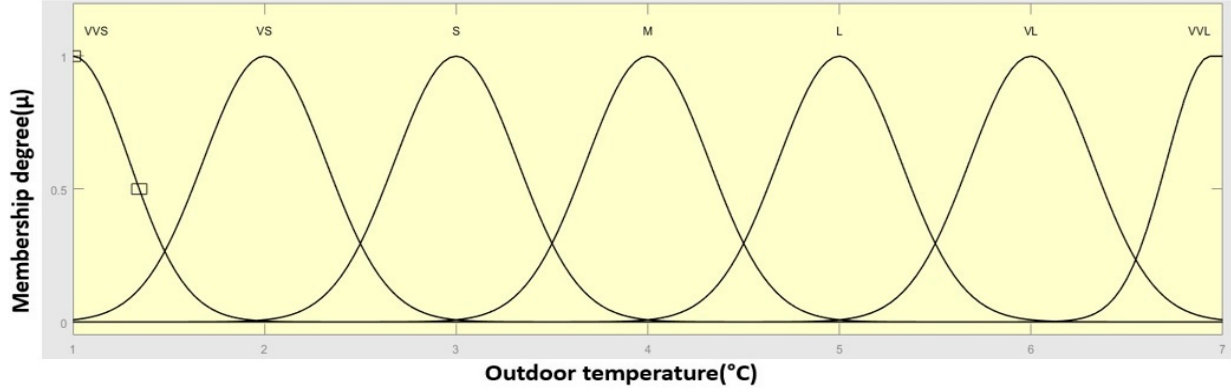
Figure 9. Membership functions of the outdoor temperature. VVS: very very small, VS: very small, S: small, M: medium, L: large, VL:very large, VVL: very very large.